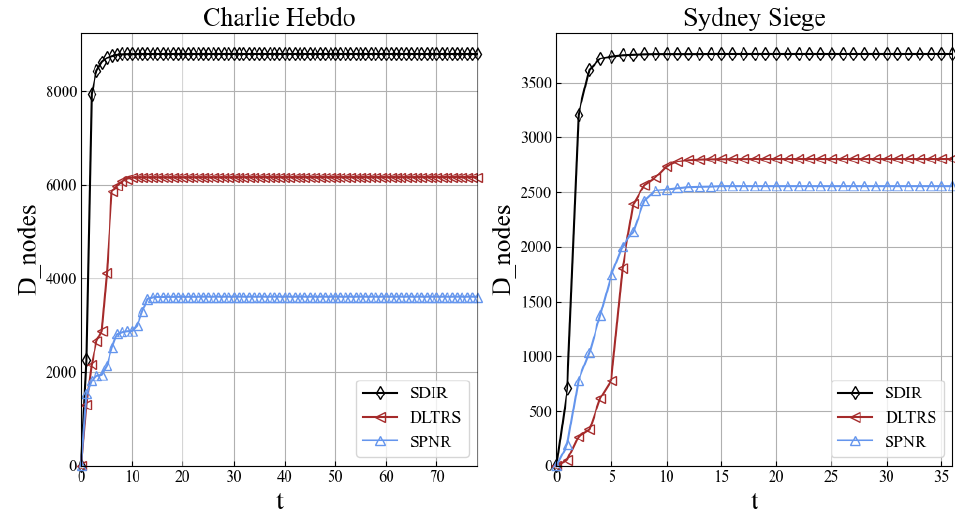
Figure 7. The comparison of anti-rumor influence